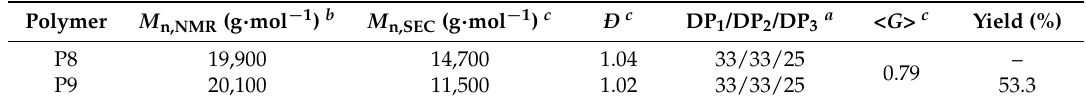
Table 4. Characteristics of P8 and P9